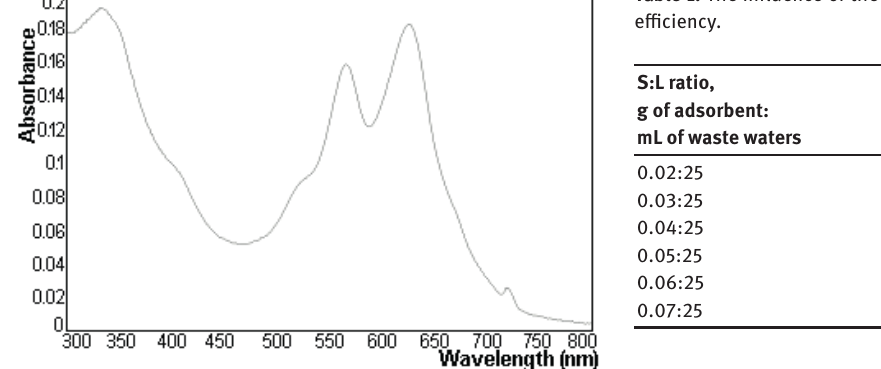
Figure 4: UV–VIS spectrum of the used waste water.